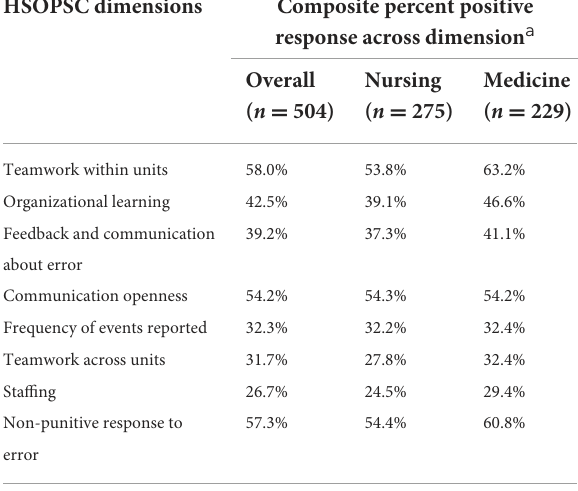
TABLE 1 Composite percent positive responses of HSOPSC dimensions overall and divided by